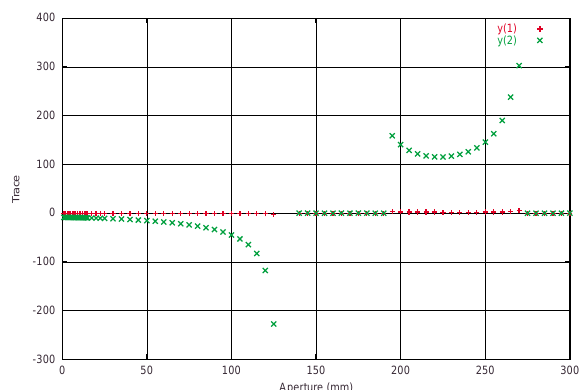
FIG. 4. (Color) First-order and second-order y chromaticities as a function of aperture. The fringe field shape is given by the default Enge coefficients.